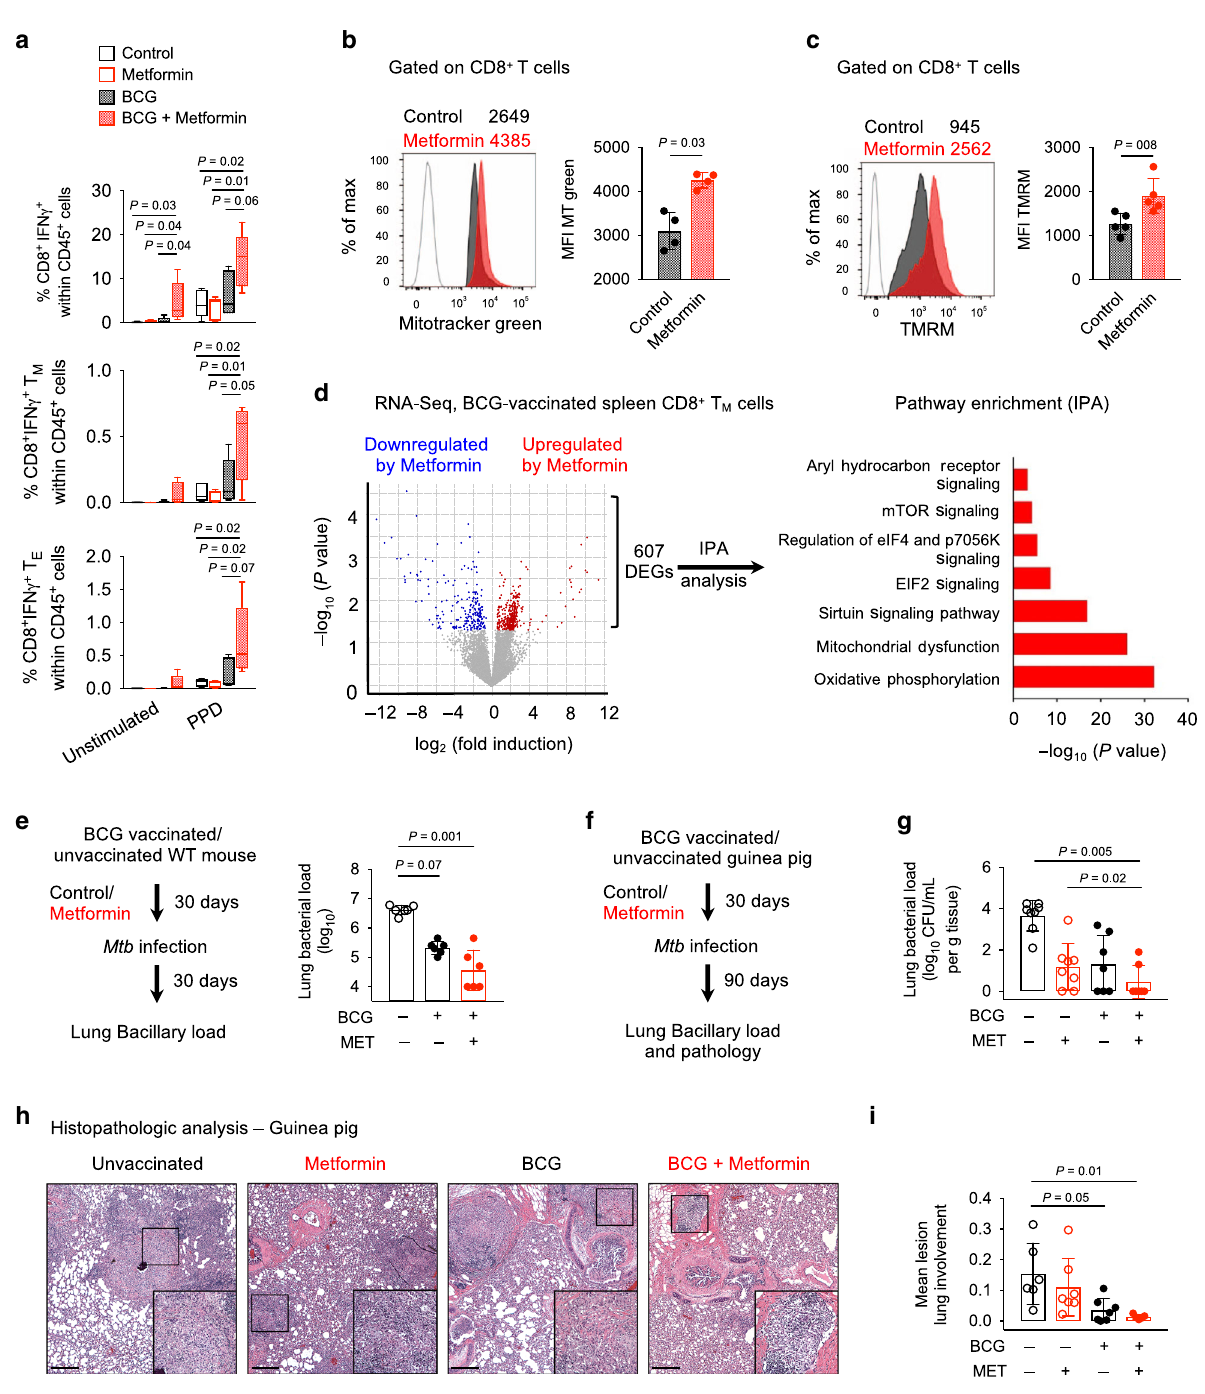
Fig. 5 Metformin promotes BCG vaccine immunogenicity and ef fi cacy. a PPD-speci fi c response of spleen cells, analyzed by fl ow cytometry. Data on IFN γ producing CD8 + T, T M , and T E cells. n = 5 mice/group. Box-and-whisker plot show the median, 5 and 95 percentiles, one-way ANOVA with Turkey ’ s multiple comparison test. b , c Mitotracker green b TMRM c staining of splenic CD8 + T cells from control and metformin-treated BCG-vaccinated WT mice. b n = 4 mice/group; c n = 5 mice/group. means ± SD, Mann – Whitney U test. d Changes in gene expression in CD8 + T M cells from BCG-vaccinated mice treated or not with metformin. IPA analysis of 607 DEGs. n = 5 mice/group. e Schematic of Mtb infection of metformin-treated BCG-vaccinated mice. Lung bacillary load at 30 days post infection (p.i) is shown. n = 6 mice/group. f Schematic of Mtb infection of metformin-treated unvaccinated and BCG- vaccinated guinea pigs. g Lung bacillary load in unvaccinated and BCG-vaccinated Mtb -infected guinea pigs treated or not with metformin. n = 6 – 7 animals/group. h Light micrographs of hematoxylin and eosin (H&E) staining of lung sections from animals in g . Magni fi cation for main image ×40 (scale bars, 50 μ m) and insert ×100. i Morphometric analysis of lung sections shown in h indicating the mean lesion lung involvement from each guinea pig. n = 6 – 7 animals/group. Data in a – c , e is representative of two independent experiments. Guinea pig data in g and i is from one experiment. Data in e , g , and i , means ± SD, Kruskal – Wallis test with Dunn ’ s multiple